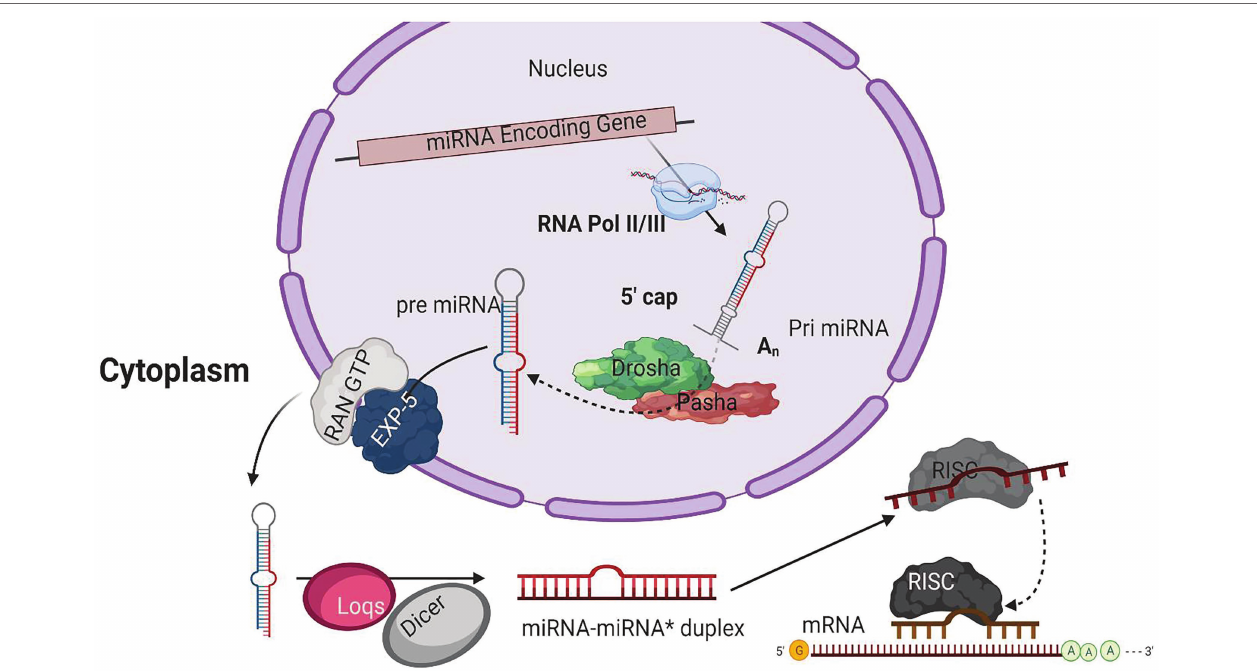
FIGURE 1 | A typical model for miRNA biogenesis. RNA polymerase II(RNA pol II), transcribing miRNA gene into a hair-loop structure known as the pri-miRNA. The Drosha/Pasha microprocessor complex process pri-miRNA to pre-miRNA in the nucleus. The pre-miRNA is exported into the cytoplasm in a RanGTP/Exp-5 dependent manner. The pre-miRNA is processed by Dicer-1 (Dcr-1) and Loquacious (Loqs) to form the miRNA-miRNA * duplex within the cytoplasm. The duplex strands are then sorted, and the miRNA strand is loaded into the RISC complex that typically includes Argonaut 1